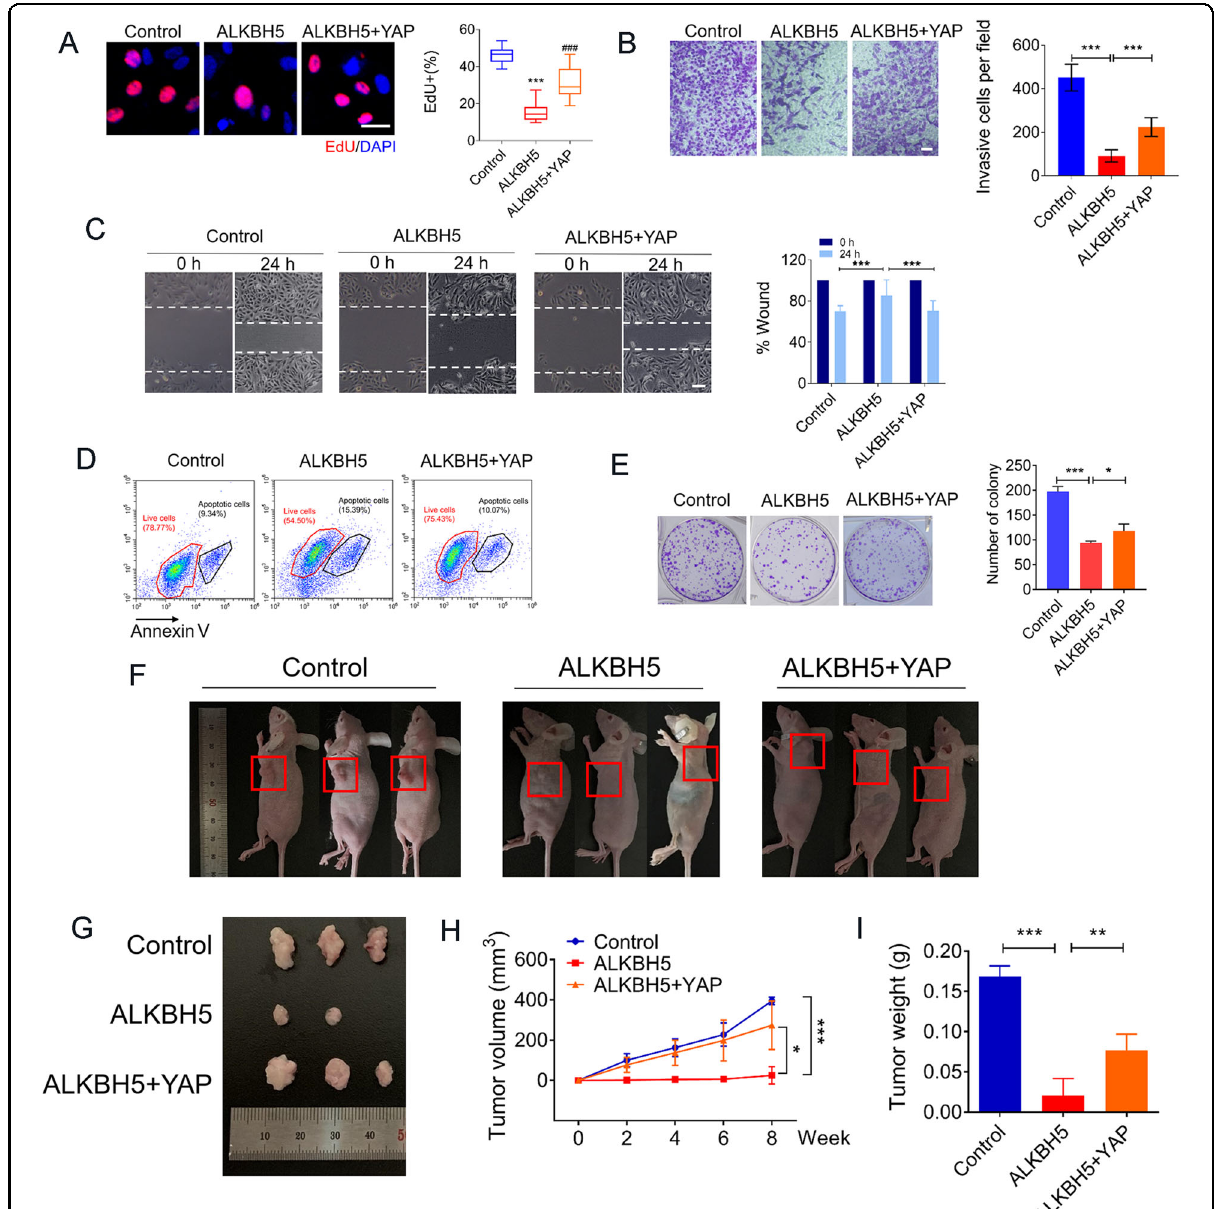
Fig. 5 YAP abrogates the inhibition effects of ALKBH5 both on human osteosarcoma cell viability and tumor growth in the xenograft mouse model. A EdU staining showing the reversing effects of YAP on proliferation inhibition of U2OS cells induced by ALKBH5 overexpression (Bar: 25 μ m, n = 5). B The effects of YAP on the weakening of ALKBH5 anti-invasion ability detected by Transwell assay (Bar: 150 μ m, n = 6). C Cell metastasis analyzed by migration assays (Bar: 200 μ m, n = 7). D Annexin V-FITC/PI staining analysis of apoptotic cells ( n = 3). E Representative images of colony-formation cells ( n = 3). F 143B cells transfected with empty plasmid (control), alone ALKBH5 plasmid or together with YAP plasmid, and then injected cells into female nude mice. Representative photographs of the gross 143B tumors 8 weeks after injection. The red square marks the location of the tumor ( n = 3). G The image showing the comparison of the excised tumor size of 143B xenografts in nude mice. H Curve diagram showing the volume of the tumor measured once 2 weeks throughout the experiment. I Weight of tumor tissues removed from nude mice. Data are expressed as mean ± SEM. * P < 0.05; ** P < 0.01; *** P < 0.001 (vs. the fi rst group). ### P < 0.001 (vs. the second group).